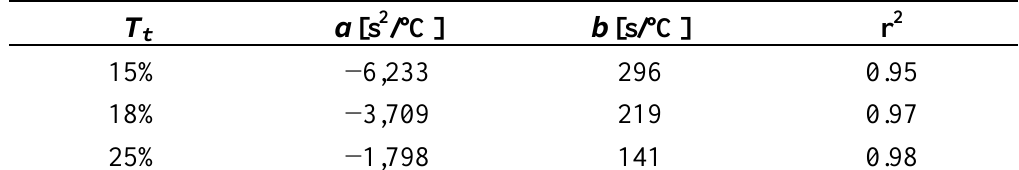
Table 1. Correction factors as a function of the cooling time k = a + b ∙ t for values of the threshold temperature of 15%, 18% and 25%.